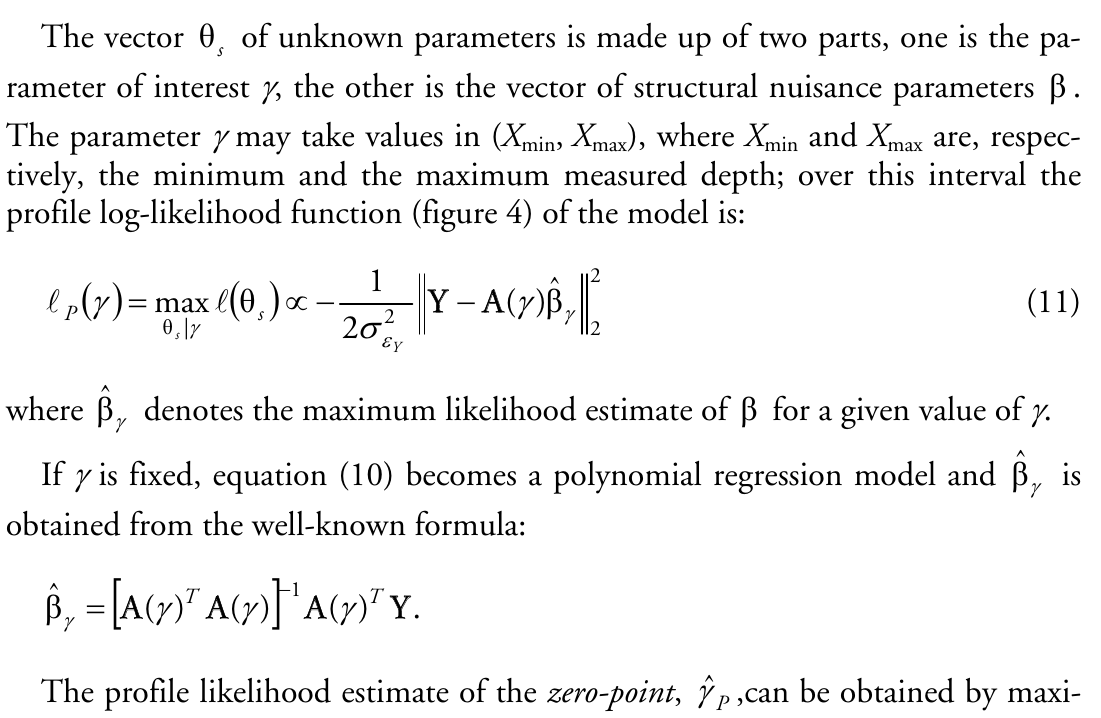
Figure 4 – Graph of the Profile log-Likelihood Function: interest (cid:74)